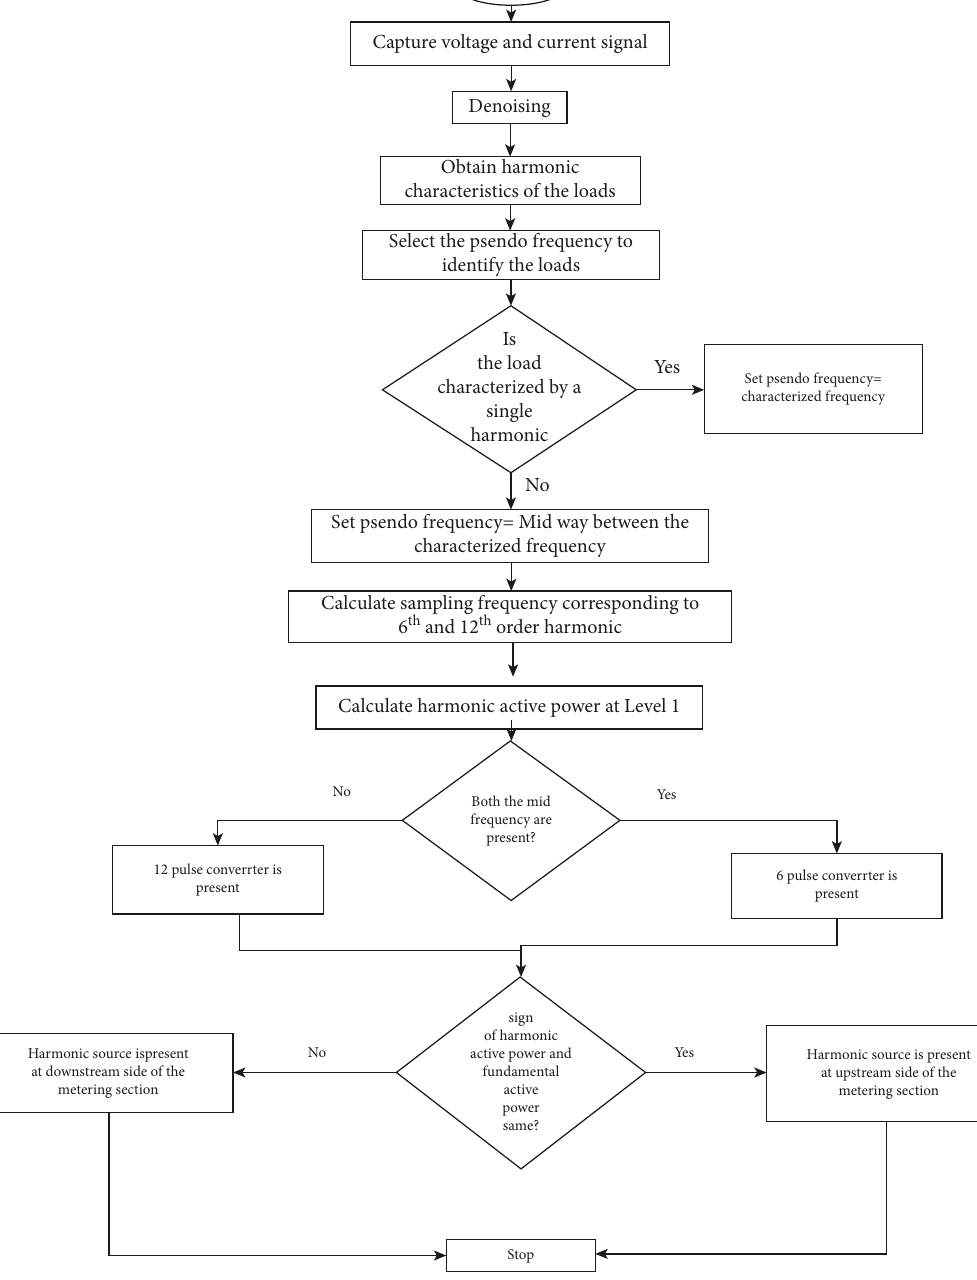
Figure 7: Flowchart of the source identification